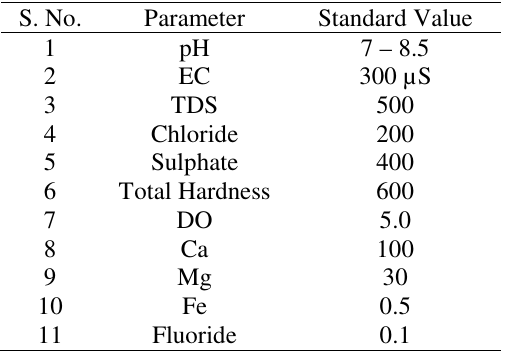
Table 2. Standard values for Potability.